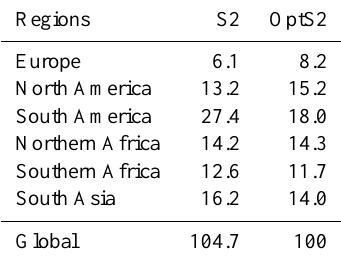
Table 2. Biogenic emission estimates of methanol (inTgyr − 1 ) in large world regions before and after 54